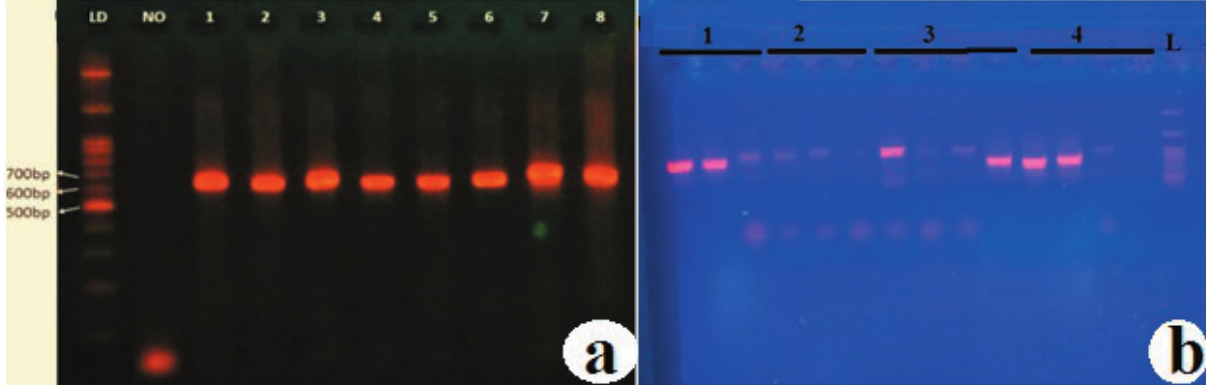
Figure 3 . Agarose gel (1.5%) showing the PCR amplified ITS of the plant materials used in the present study. Note . Fig. a) Nalini et al. (2003) (1- Tamarix arceuthoides , 2- T. ramosissima , 3- T. chinensis , 4- T. szowitsiana , 5- T. meyeri , 6- T. androssowii , 7- T. mascatensis and 8- T. aucheriana ); Fig. b) 1- Murry and Thompson (1980); 2- Kit (DNP TM Kit), 3- Sahu et al. (2012), 4- Bi et al. (1996); L) 100 bp DNA